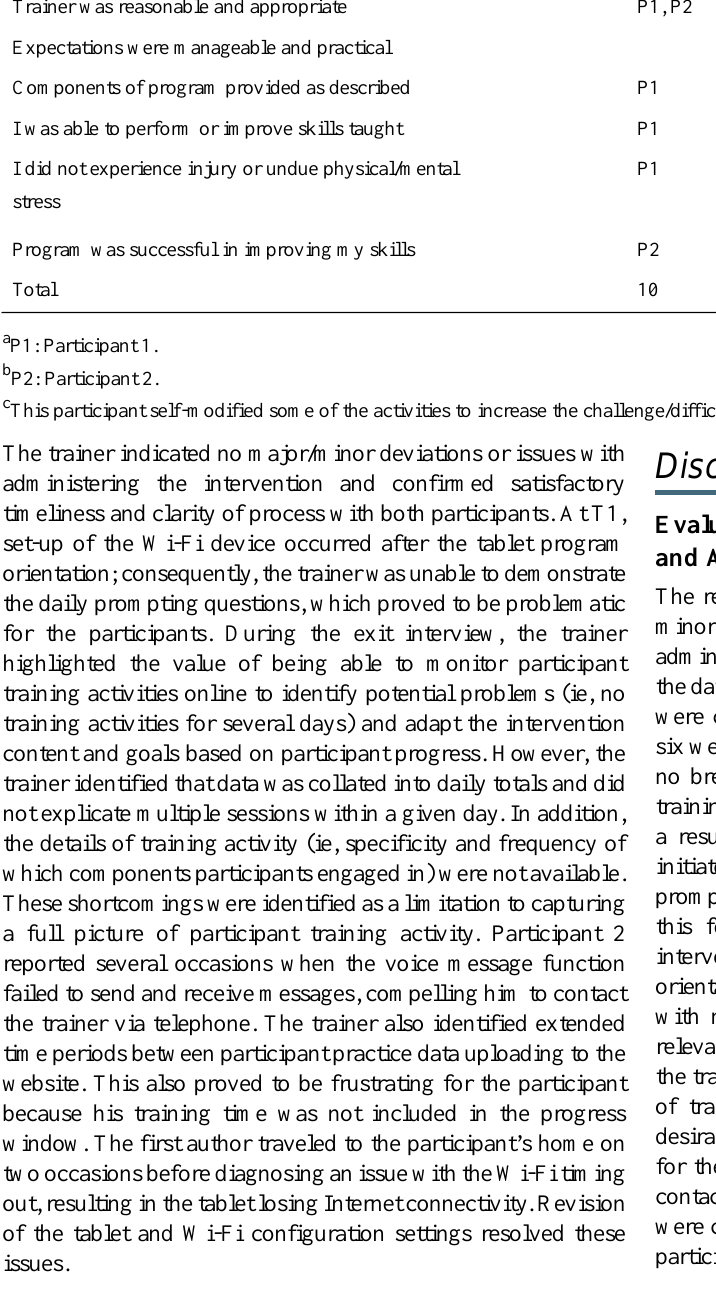
Strongly disagreeDisagreeAgreeStrongly